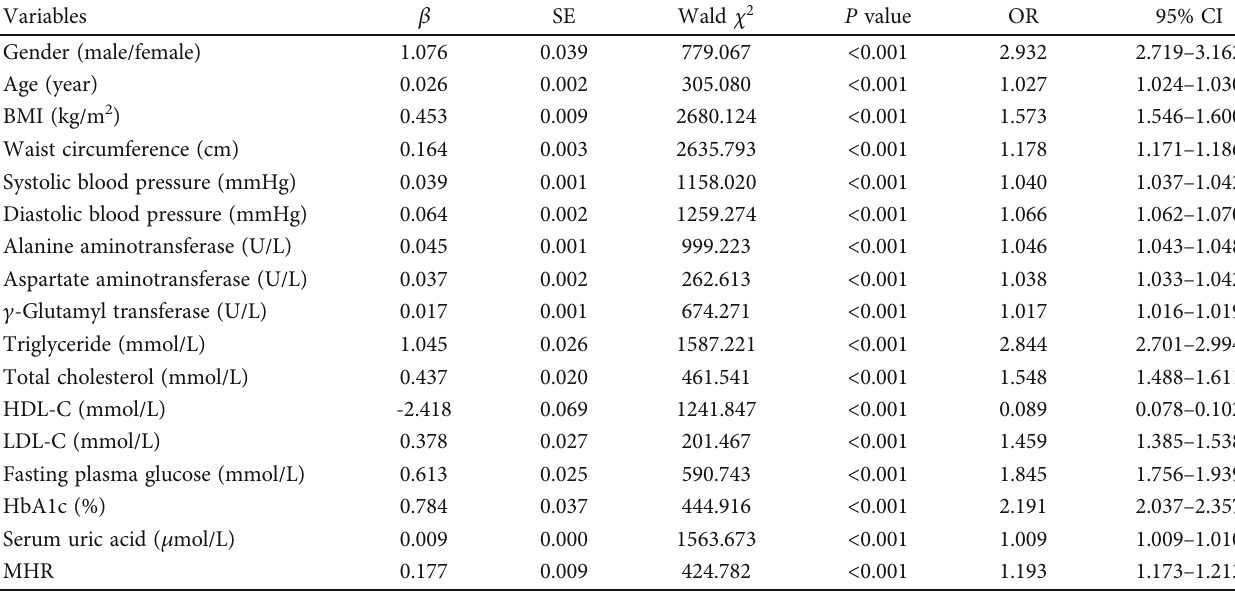
Table 4: Univariable analysis for factors associated with NAFLD.